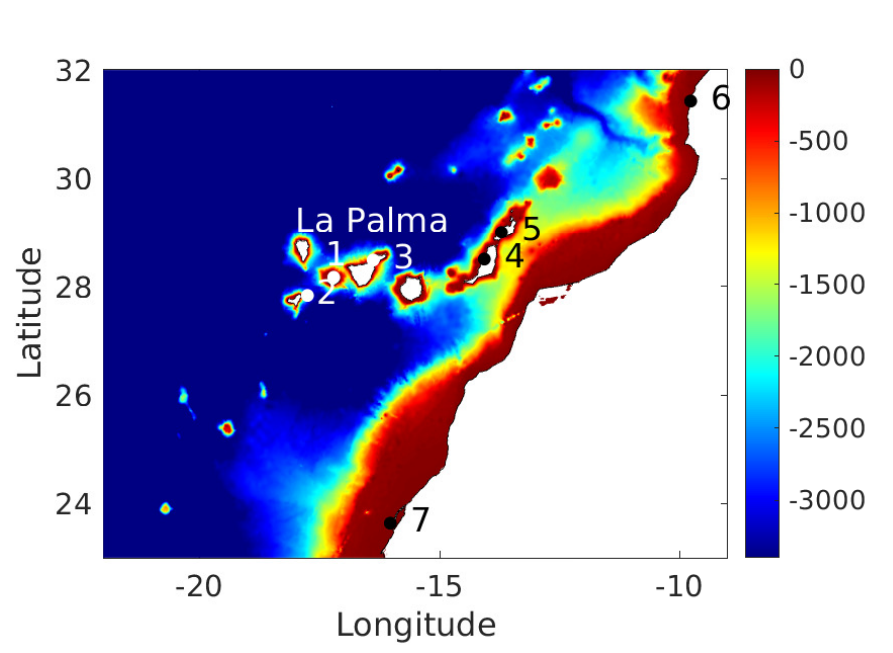
Figure 1. Model domain. Points where wave heights are obtained: 1 Gomera; 2 El Hierro; 3 Pto de la Cruz (Tenerife Island); 4 Fuerteventura; 5 Lanzarote; 6 Essaouira; 7